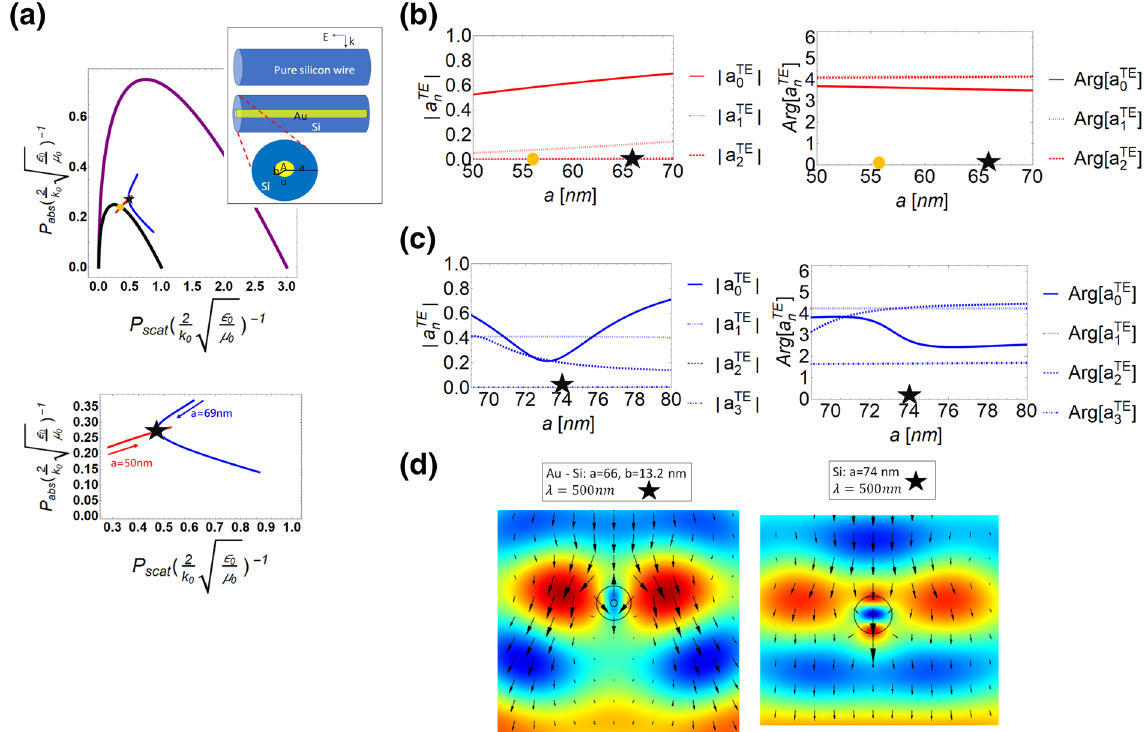
Figure 2. Power distributions of two different systems by tuning sizes are shown in the power diagram ( a ). Insert shows these two systematic configurations. Red line is for a gold-silicon core-shell system. Here the radius ratio (inner to outer) is fixed constant, 0.2. Blue line is for a homogeneous silicon system. When tuning a = 50 nm to 70 nm of a gold-silicon core-shell system, the corresponding power distribution shown in the red line, goes through N = 0 to N = 1 region. An orange dot denotes that the system is cross boundary of N = 0 . In the blue line, it shows that the size of silicon nanowire is tuned from 69 to 80 nm. An intersection of red and blue lines (marked by a black star) denotes two systems have same power in absorption, scattering, and extinction. In below ( a ), it reveals the detail of power distribution for the red and blue lines. In ( b ) and ( c ), we study the constitution of dominant scattering coefficients for the gold-silicon core-shell and homogeneous silicon systems in magnitudes and phases, respectively. Here the relative permittivity of gold we use is − 2.81 + i 3.19 and that of silicon is 18.5 + i 0.63 . The operating wavelength is 500 nm. In ( d ), we plot the electric field distribution for